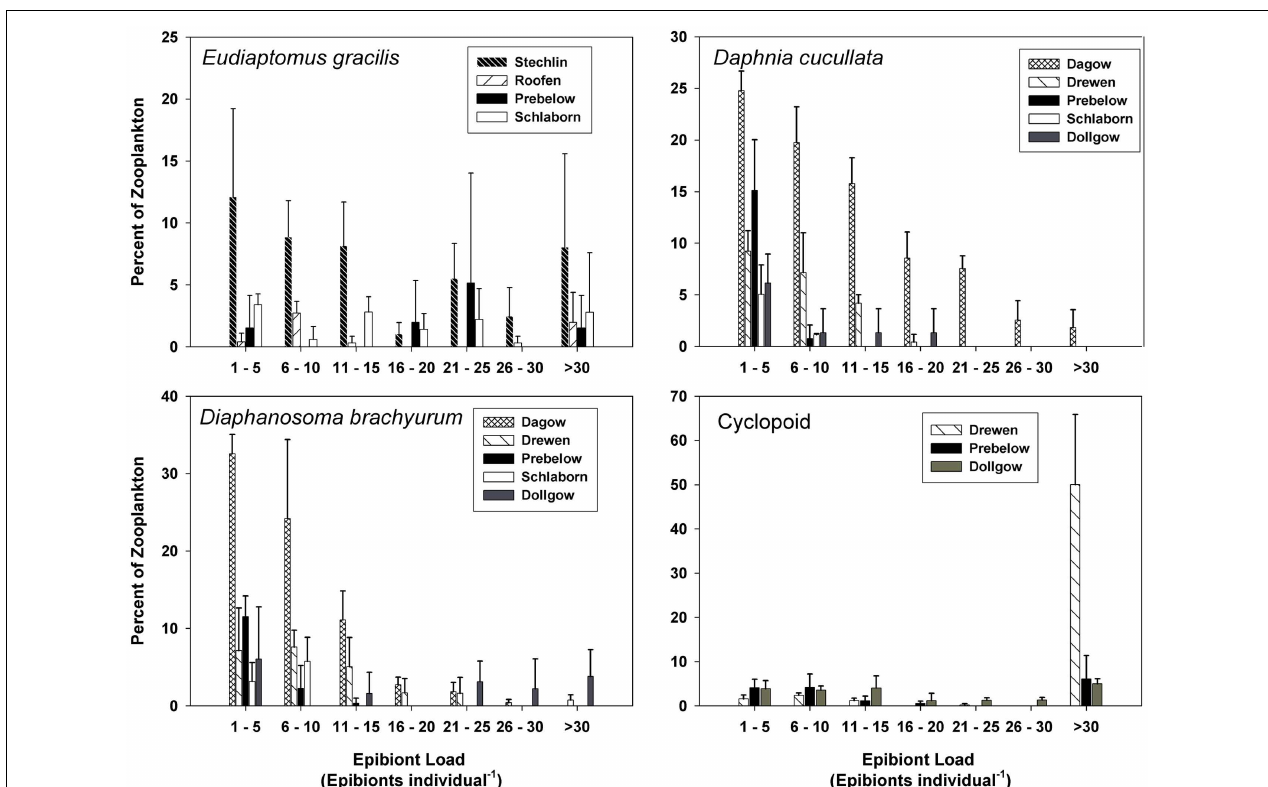
FIGURE 4 | Frequency distribution of epibiont load (number of epibionts per individual, mean ± SD, n = 3) on E. gracilis, D. cucullata , D.